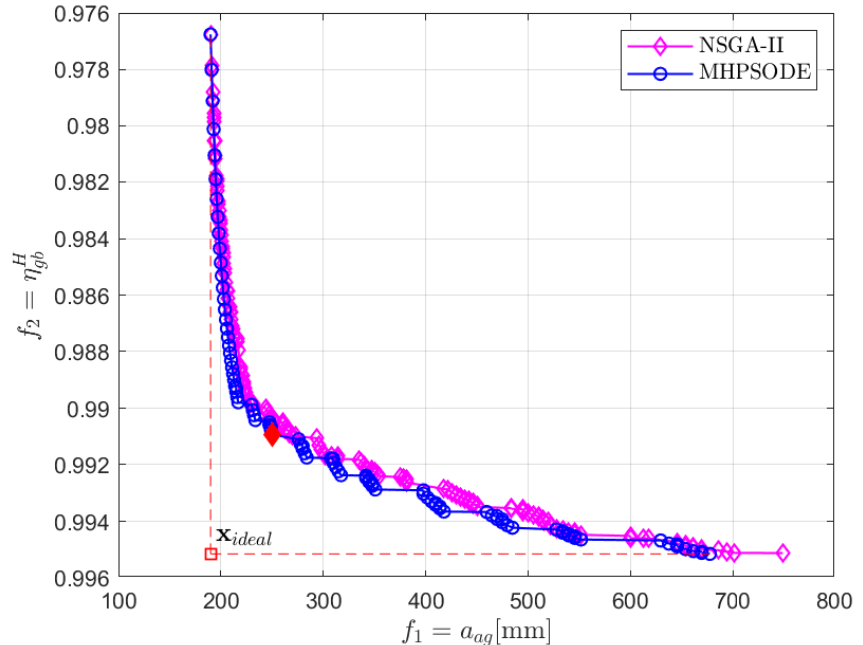
Figure 3. Illustration of the Pareto frontier for the objective functions: center distance and planetary gearbox efficiency.